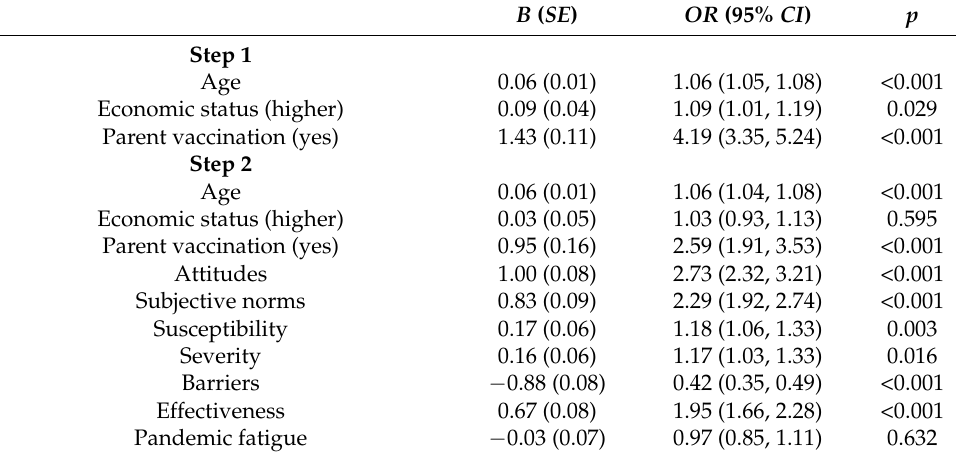
Table 3. Multiple logistic regression for the intention to vaccinate the child/ren ( N = 2483).